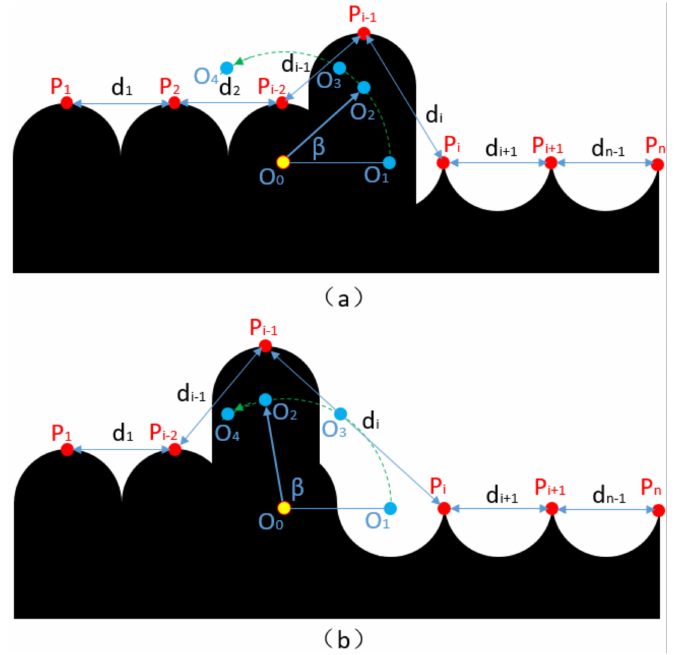
Figure 15. Projection diagram of the rope arrangement in the case of the rope clamping failure. ( a ) β increases from 0 ◦ to 60 ◦ . ( b ) β increases from 60 ◦ to 120 ◦ .